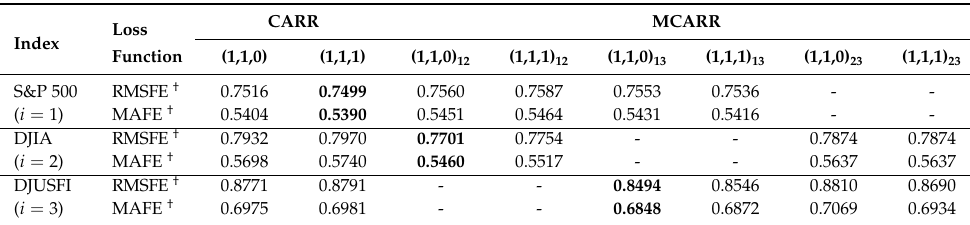
† Estimates are rescaled by multiplying 10 2 . The best out-of-sample closing price forecast performances for each index series are highlighted in